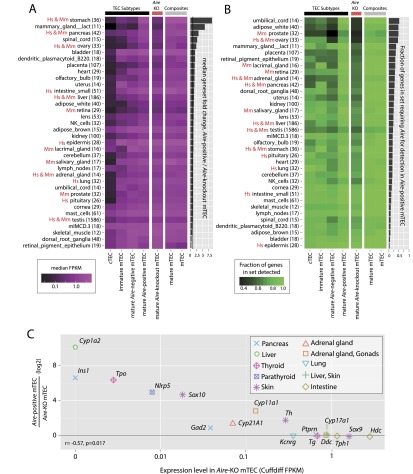
Requirement for Aire reflects known AIRE deficiency pathologies. (A) The median expression level (FPKM) of sets of genes restricted in expression to single physiological samples (excluding the thymus) of the GNF GeneAtlas (based on dynamic step criteria; see Methods; Supplemental Fig. 6) (gene numbers indicated in parentheses) for each TEC population. Gene sets are sorted by the fold change in median expression level between mature Aire-positive and mature Aire-KO mTEC (accompanying bar chart). In both A and B, gene sets representing organs affected by AIRE deficiency in APS-1 (“Hs”) and the corresponding mouse model (“Mm”) are indicated. (B) The fraction of the same sets of genes that are detectable (<5% local FDR) in each TEC population (see Methods; Supplemental Fig. 3); gene sets are sorted by the increase in the fraction of these genes detected in mature Aire-positive mTEC compared to Aire-KO TEC. (C) Relative expression of known APS-1 autoantigens in mature Aire-positive wild-type and knockout TEC (Shikama et al. 2009). Induction by Aire expression is significantly negatively correlated with the transcriptional level of these genes in mature Aire-KO mTEC.